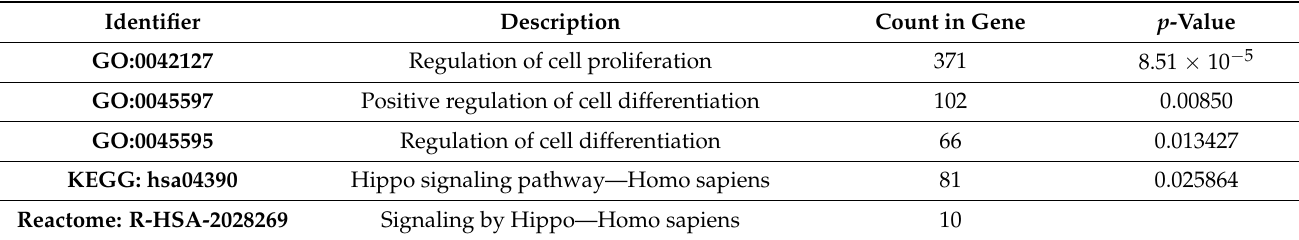
Table 1. Functional enrichment analysis after targeted filtration of DEGS related to cell proliferation/differentiation and Hippo signaling.